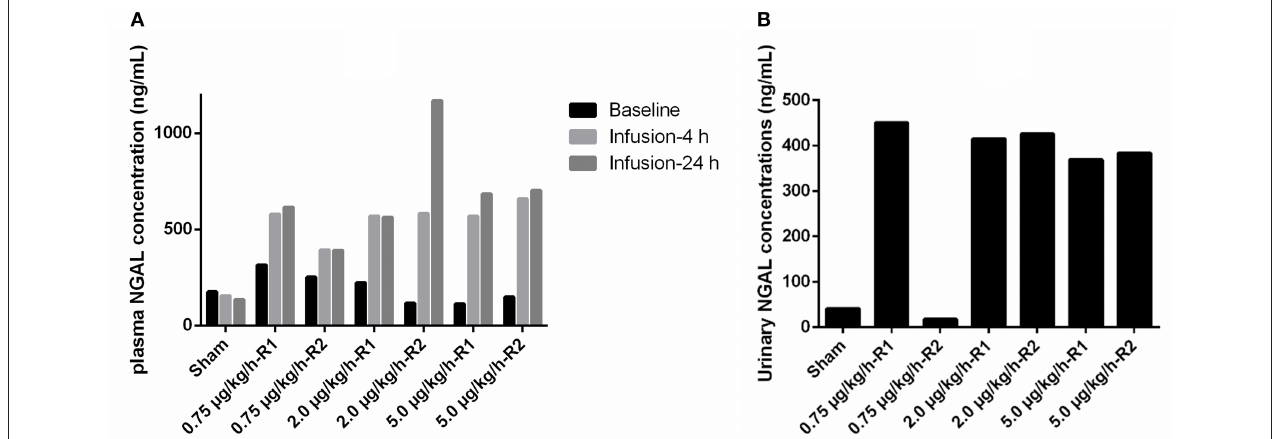
FIGURE 7 | (A) Plasma neutrophil gelatinase-associated lipocalin (NGAL) concentrations at baseline, and at 4 and 24h after the start of 36h a continuous intravenous infusion of either 0.9% NaCl solution (6 ml/kg/h, sham, n = 1) or 0.9% NaCl solution (6 ml/kg/h) in combination with LPS (0.75; 2.0 and 5.0 µ g/kg/h, n = 2/group). (B) NGAL concentrations in voided urine, collected after 4h after the start of the respective